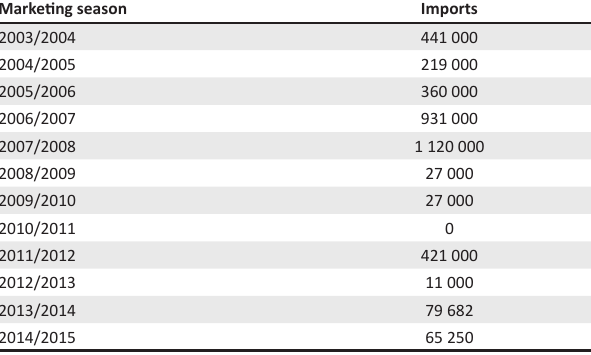
FIGURE 1: The demand for maize required to produce animal